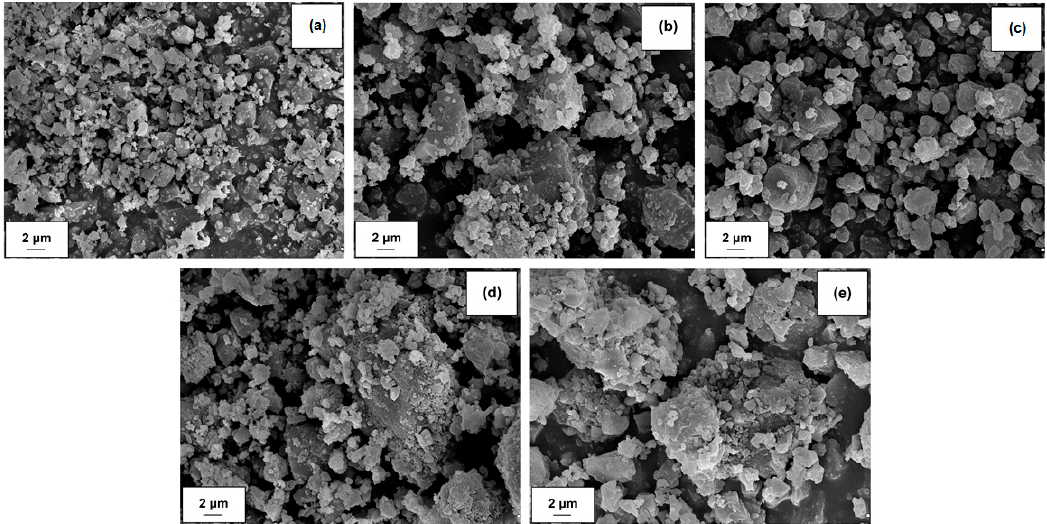
Figure 3. SEM images of alumina ( a ), lignosulfonate ( b ), lignin ( c ), Al 2 O 3 -lignosulfonate hybrid material ( d ) and Al 2 O 3 -lignin hybrid material ( e ).